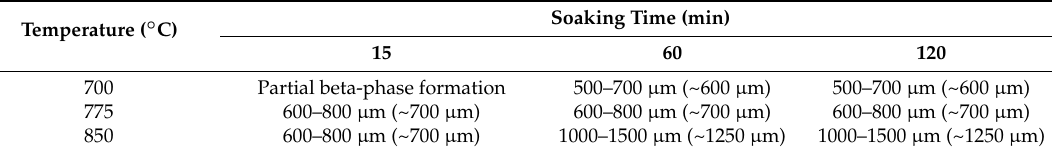
Table 3. Average grain size of beta-phase as a function of soaking temperature and duration.